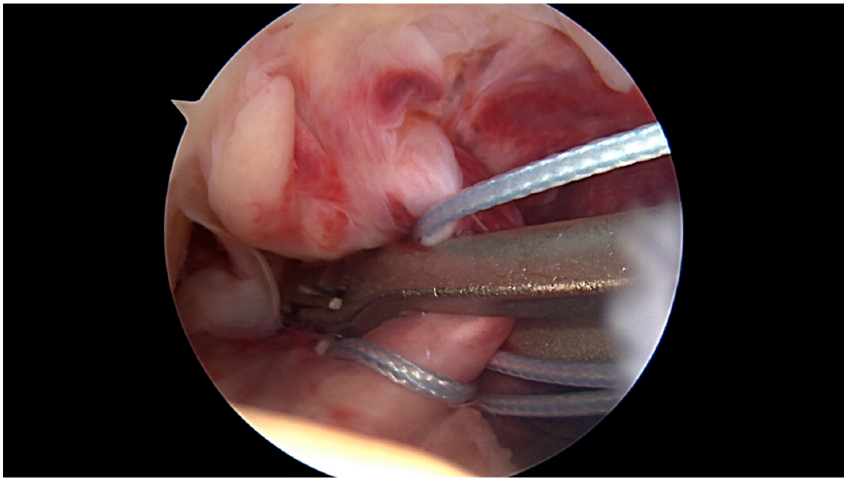
Figure 4. Using the labral scorpion suture passer, a No. 2 FiberWire ® is passed 3 times through the ACL remnant.